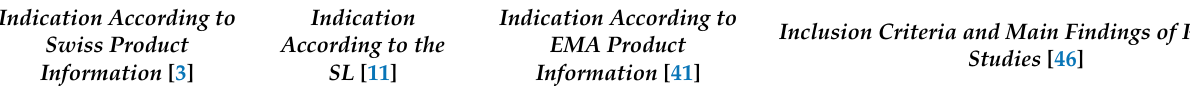
Table 3. Ofatumumab (Kesimpta ® ), approval CH